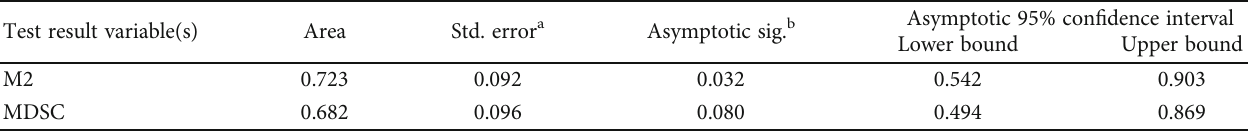
Table 3: ROC curve analysis about the radiotherapy of NSCLC patients (area under the